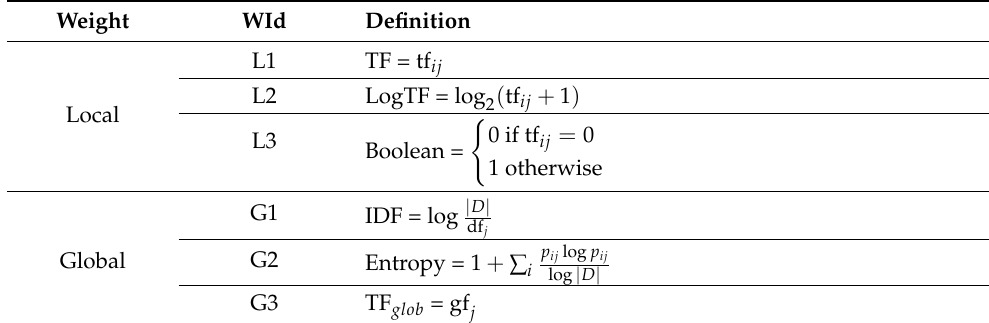
Table 1. Local and global weight functions exploited in